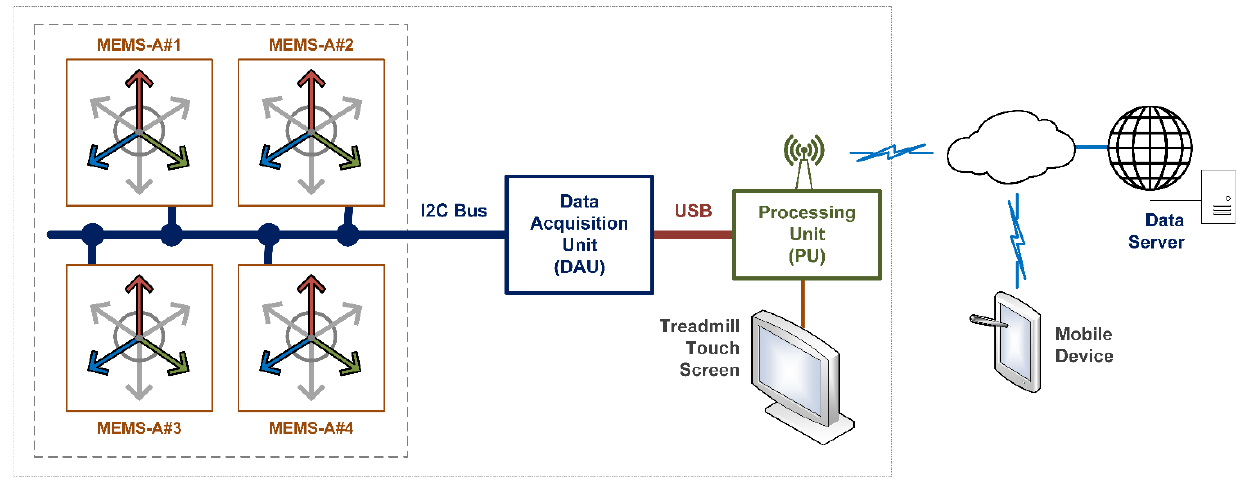
Figure A2. Block diagram of the AccTre system: MEMS-A connected to the DAU via an I 2 C bus; DAU linked to the PU via an USB connection; graphical user interface for biofeedback to the runner on the treadmill touch screen; transmission of processed data to a cloud server and access to the data set through a mobile device.